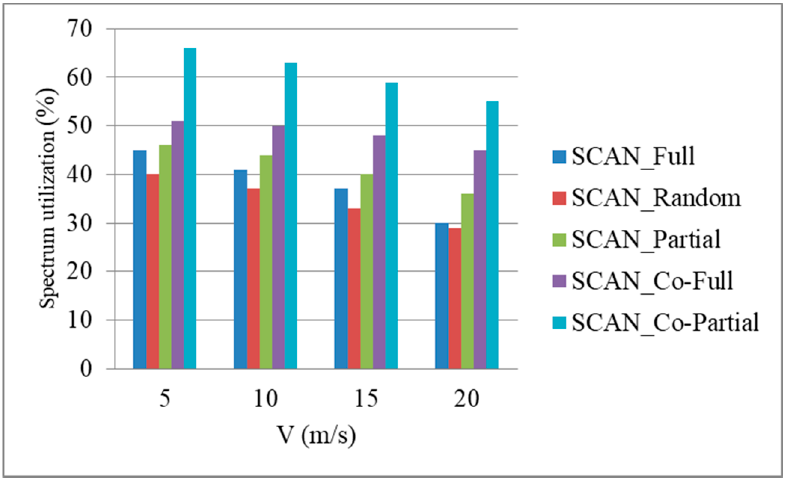
Figure 14. Spectrum utilization ratio under different moving speeds (PU number = 10, P PUaccess = 0.5, SU number = 10).